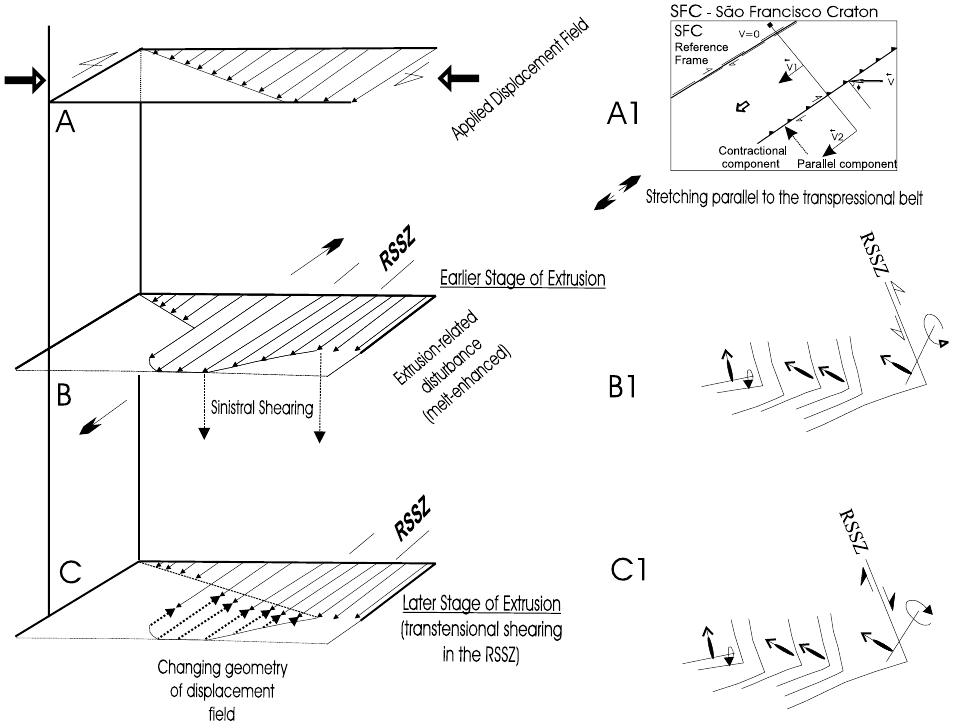
Fig. 6 – Simplified drawing showing in two dimensions (left column) the applied displacement field, and the inferred changes in the mechanical state interpreted as resulted from the extrusion tectonics. (a) regional transpressional displacement field imposed on the Paraíba do Sul Belt, resulted from the situation shown in a1; (b) Extrusion-related disturbance and extrusion of the partially molten hangingwall. Note the development of a horizontal sinistral component in the RSSZ (b 1 ) ; (c) Decrease in the relative displacement of the hangingwall, and nucleation of transtensional motion in the RSSZ and extrusion of the footwall (b) (c 1 ) . See text for a full